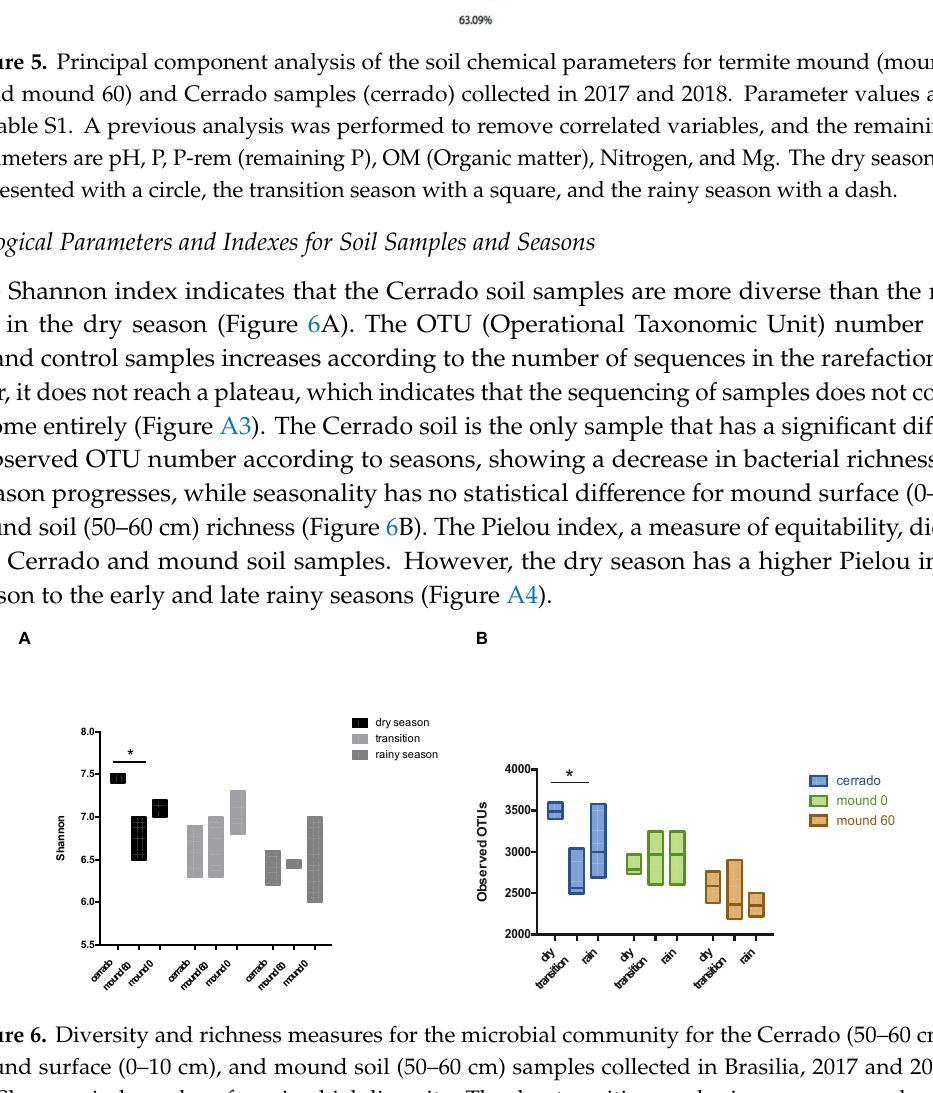
Figure 5. Principal component analysis of the soil chemical parameters for termite mound (mound 0 and mound 60) and Cerrado samples (cerrado) collected in 2017 and 2018. Parameter values are in Table S1. A previous analysis was performed to remove correlated variables, and the remaining parameters are pH, P, P-rem (remaining P), OM (Organic matter), Nitrogen, and Mg. The dry season is represented with a circle, the transition season with a square, and the rainy season with a dash.